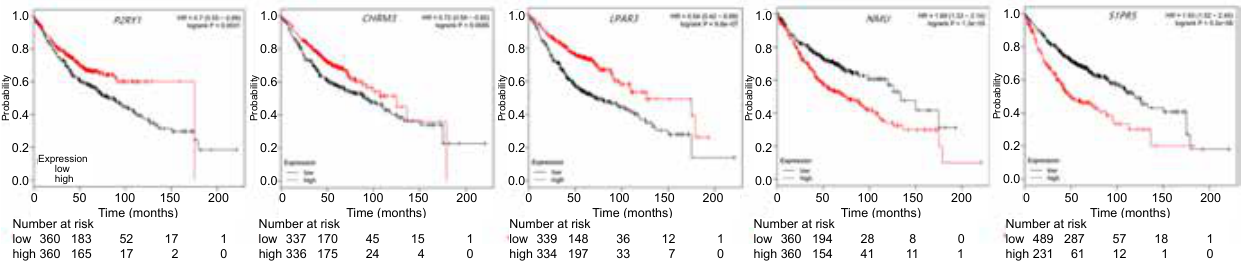
Figure 5 Prognostic values of the five key DEGs in LUAD